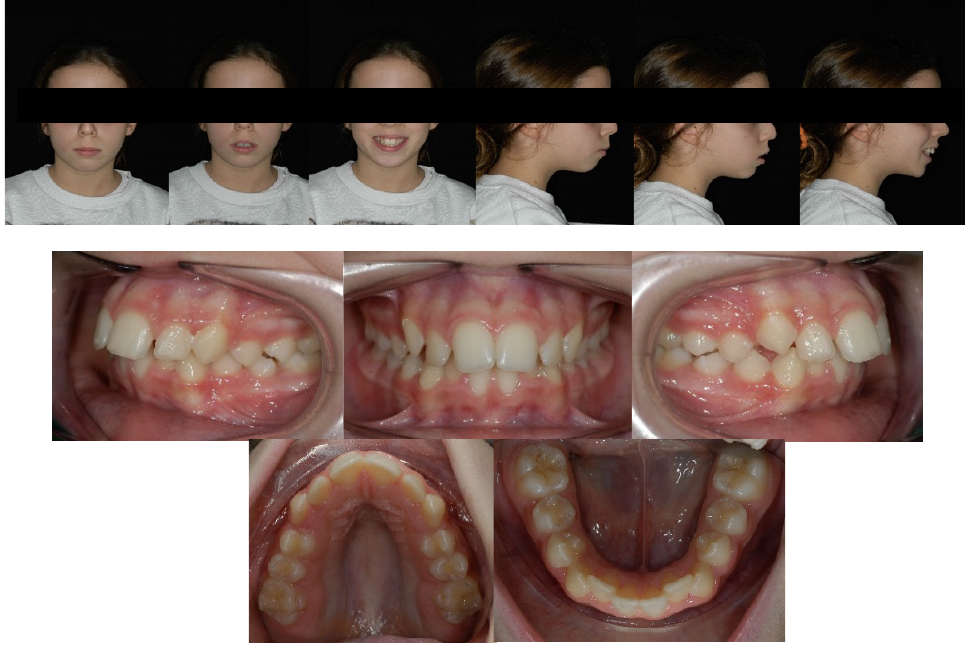
Figure 4. Pre-treatment photographs .